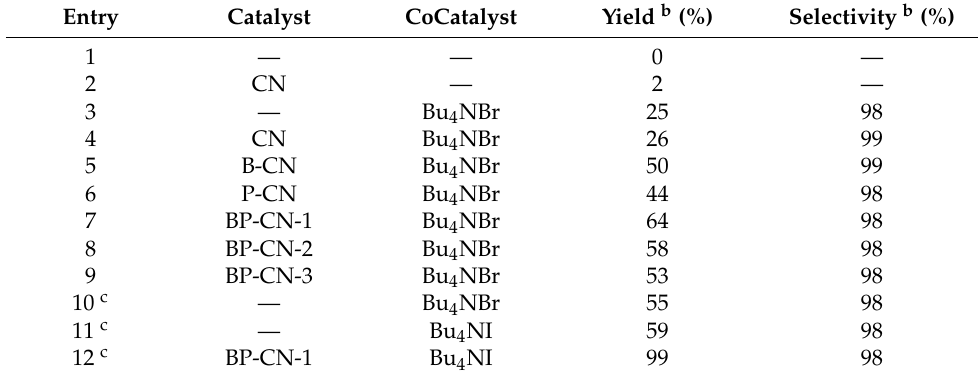
Table 2. Catalytic performance of catalysts a